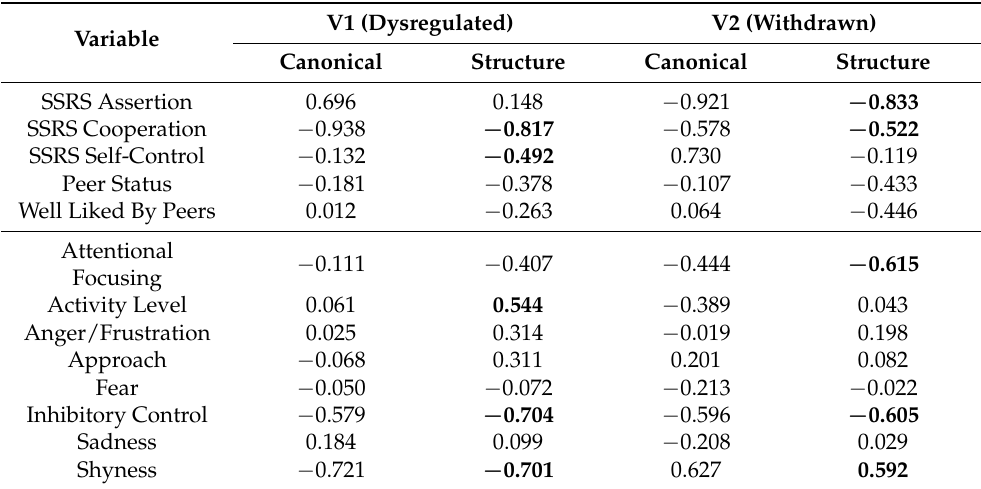
Table 2. Canonical solution for temperament predicting peer interactions for variates 1 and